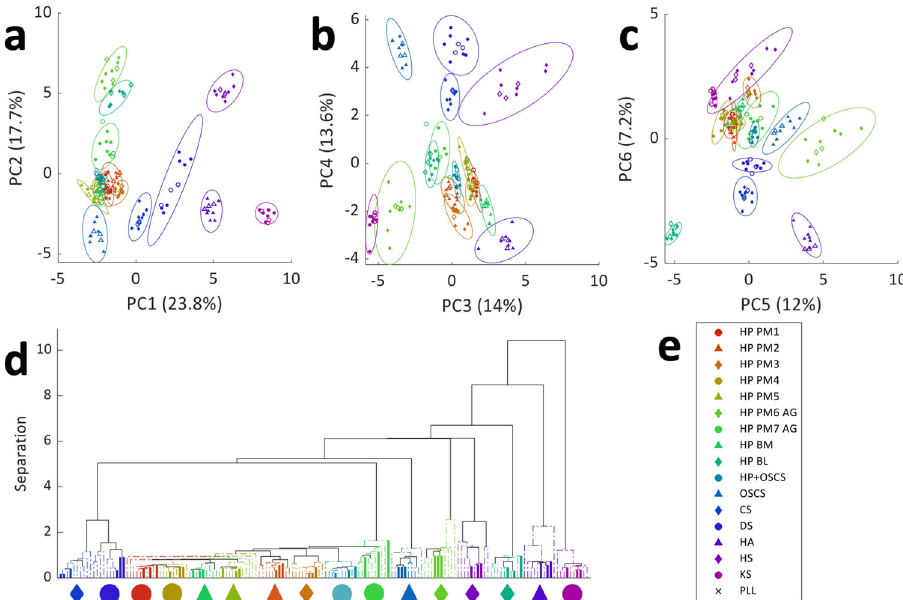
Fig. 2 PCA of 16 different GAGs. a – c Scores plots for the 6 fi rst PCs for all 16 samples, including different heparin (HP) samples. Training sets are closed symbols and test sets are open symbols. The 95% con fi dence ellipse is shown for each sample set. a PC1 and PC2, b PC3 and PC4, and c PC5 and PC6. d Dendrogram showing hierarchical clustering of GAG samples based upon the scores for PCs 1 – 6. Training samples are shown as a dashed line and test samples are shown as a solid line. Lines have been coloured to match sample identity. The associated symbol for each sample type is shown beneath each cluster. e Legend showing symbols corresponding to the GAG